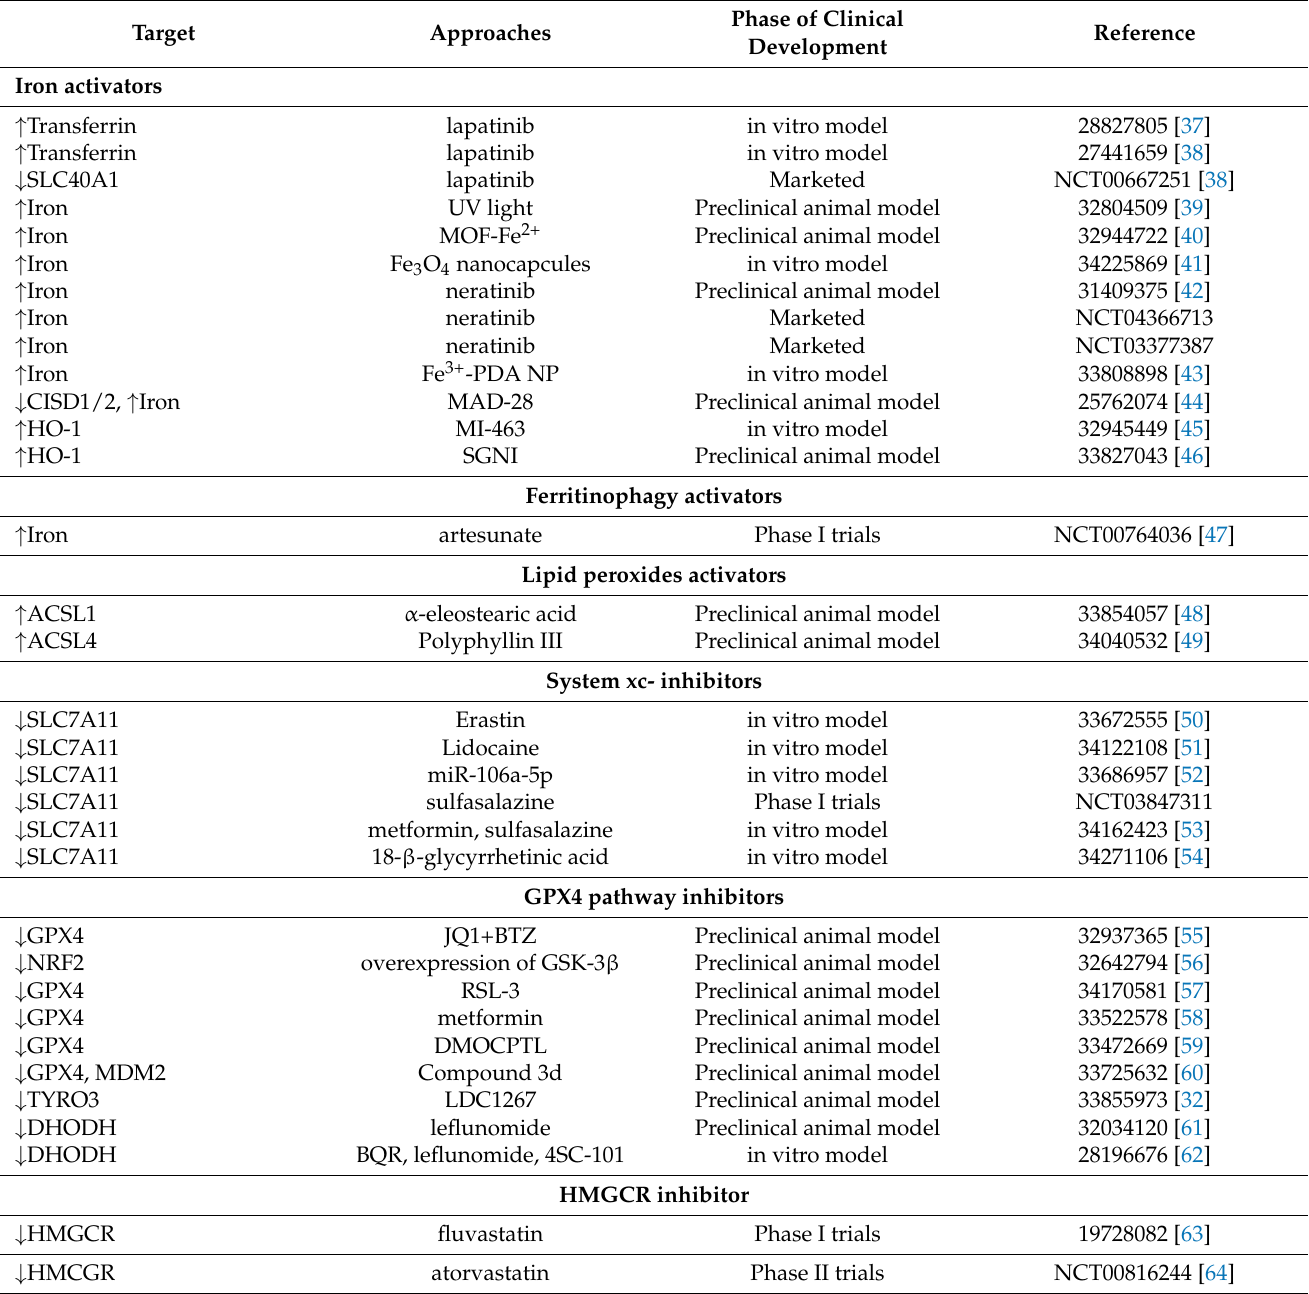
Table 2. Updated therapeutic approaches for targeting of ferroptotic pathways in